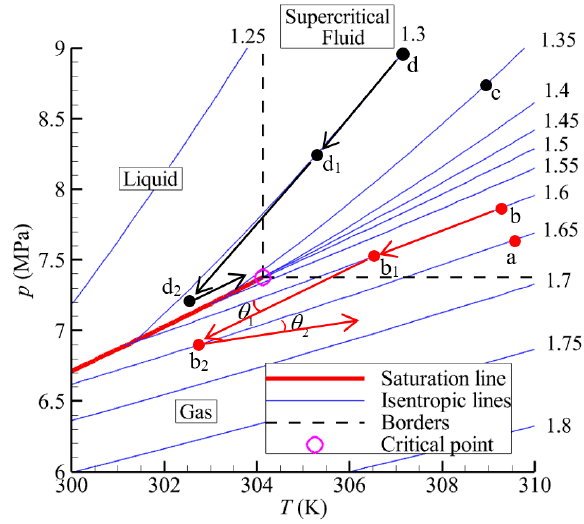
Figure 7. Expansion process of SCO 2 near impeller inlet.